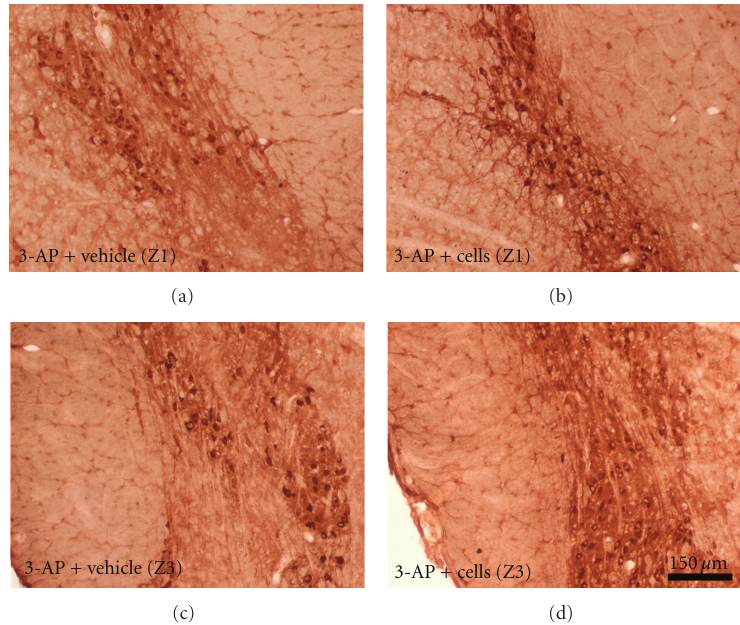
Figure 3: Immunodetection of calbindin in the inferior olive of 3-AP ataxic rats. (a) and (c) show calbindin immunostaining in two di ff erent levels of the inferior olive of 3-AP-lesioned rats separated by a distance of approximately 800 μ m. Note how HuUCBMCs grafts increase calbindin-positive cells in both zones of the structure (b, c). Scale bar: 150 μ